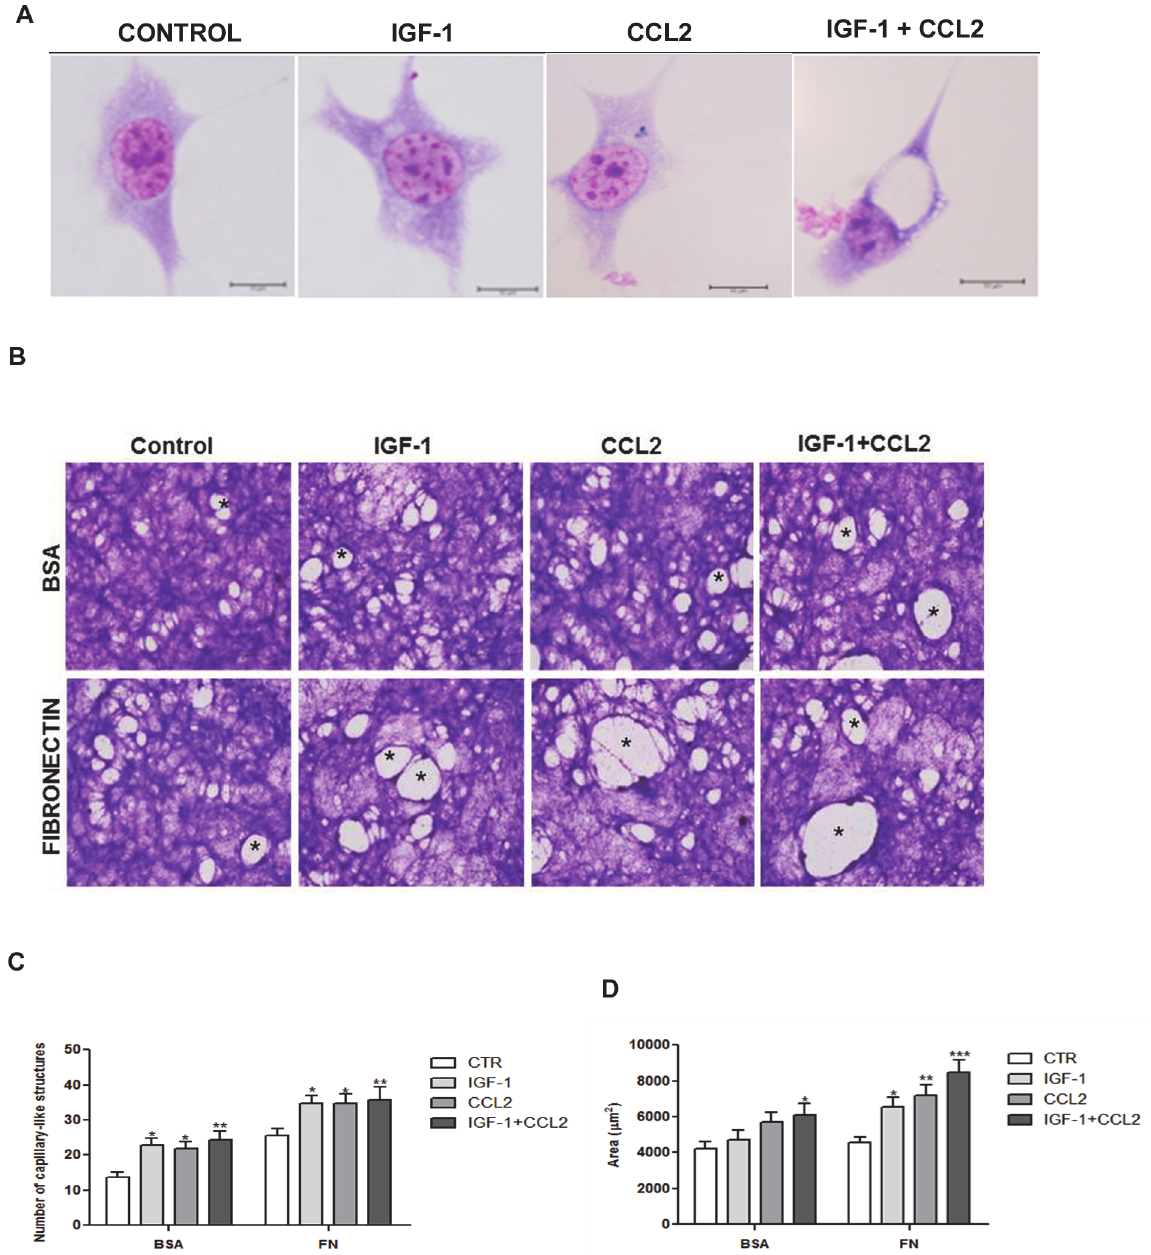
Fig 4. IGF-1 and CCL2 stimulated tEnd.1 cell morphology and tube formation. ( A ) tEnd.1 cells were treated with IGF-1 (100 ng/mL), CCL2 (10 ng/mL), or a combination of both for 24 h and analyzed by optical microscopy. Photomicrographs show intracellular lumina in tEnd.1 cells, indicated by arrows. Giemsa staining. Scale bar = 10 μ m. ( B ) tEnd.1 cells were treated with IGF-1, CCL2, or IGF-1/CCL2 for 8 days on BSA or FN coating and analyzed by optical microscopy. Photomicrographs demonstrate capillary-like structures, indicated by asterisks. Giemsa staining. Scale bar = 10 μ m. ( C ) Number of capillary-like structures. ( D ) Luminal area of capillary-like structures. Bars represent the mean ± SEM (n = 6/group). Results were analyzed by two-way ANOVA followed by Bonferroni ’ s post-test. Significant compared with control, p < 0.05 ( * ), p < 0.01 ( ** ), or p < 0.001 ( ***